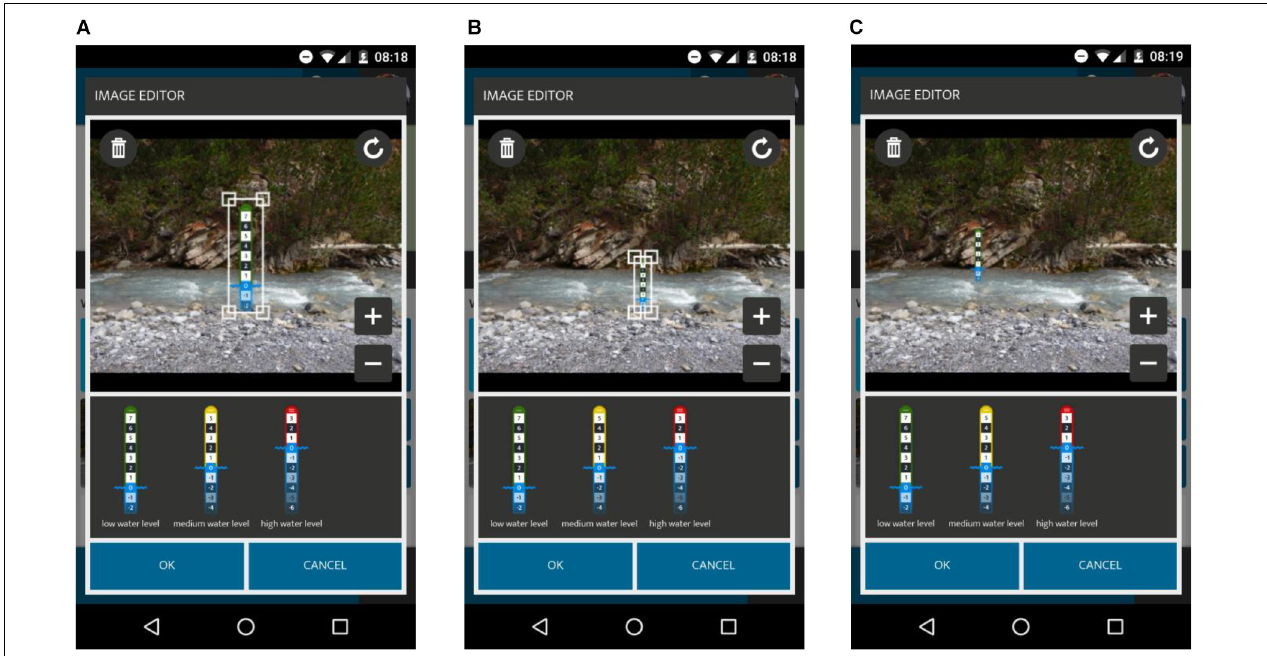
FIGURE 1 | Series of screenshots showing the insertion of the virtual staff gauge in the reference picture: (A) insert the image of the staff gauge in the reference picture, (B) scale the inserted image, and (C) move the image so that the blue line matches the stream level in the picture.